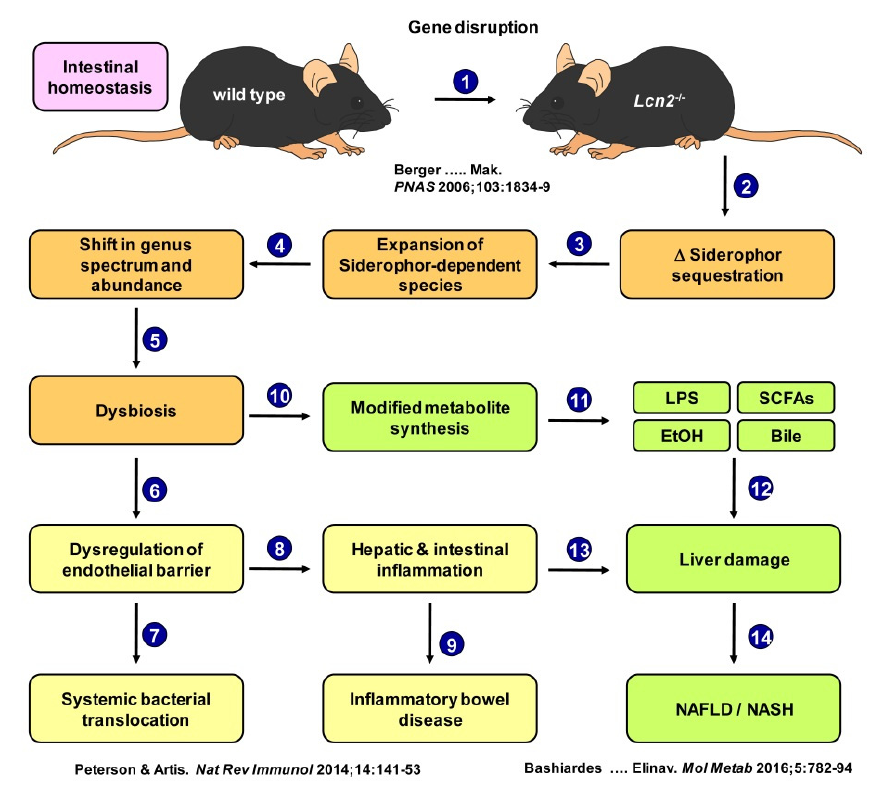
Figure 12. Model hypothesis of the effect of Lcn2 loss on the intestinal microbiome and the resulting systemic consequences. Abbreviations used are EtOH, ethanol; LPS, lipopolysaccharides; SCFAs, short-chain fatty acids. Relevant references supporting this model hypothesis are depicted in the graph and are [26,36,37].